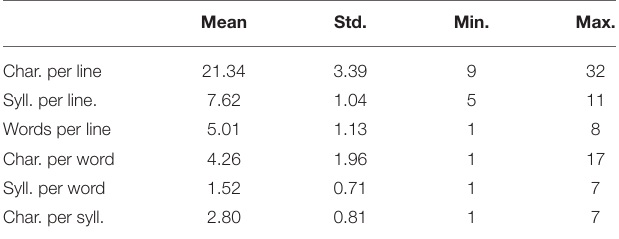
TABLE 1 | Summary statistics for annotated dataset. Mean Std.